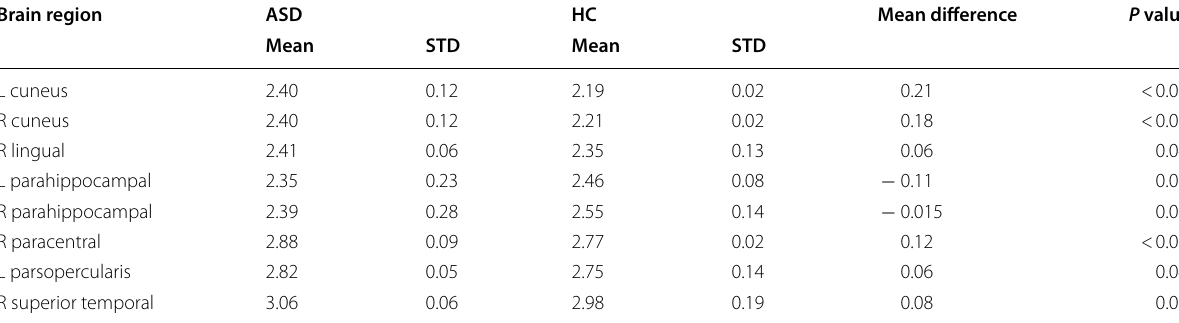
Table 7 Statistical results of cortical thickness parameter in DK atlas regions (significant differences)